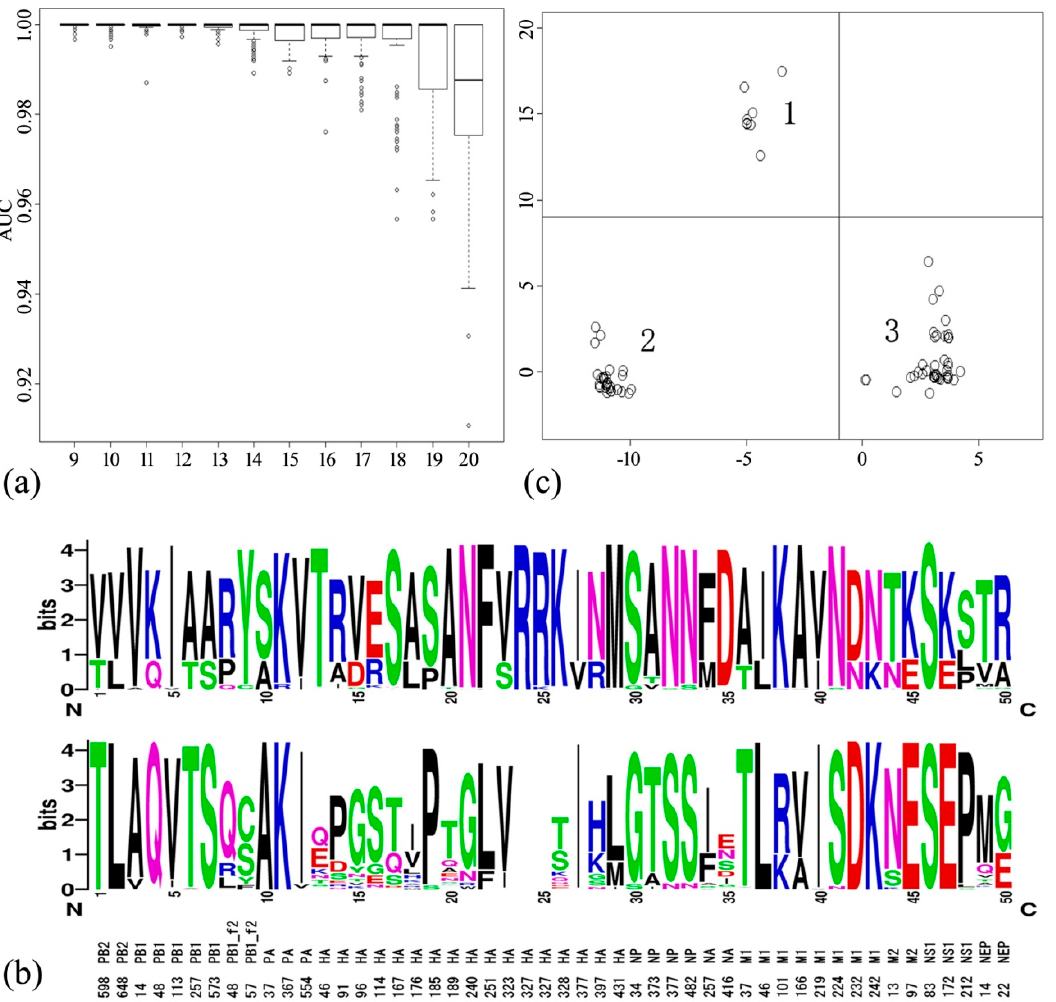
Figure 3. Minimal amino acid set for predicting AIVs. ( a ) Contributions of reduced mutation position sets. The x and y coordinates denote the cutoff (range 9–20) and the AUC values (range 0–1), respectively. ( b ) Profiles of 50 signature positions from human-origin (top) and avian-origin (bottom) AIVs. ( c ) Three patterns of human-origin AIVs clustered by the multidimensional scaling (MDS) method.